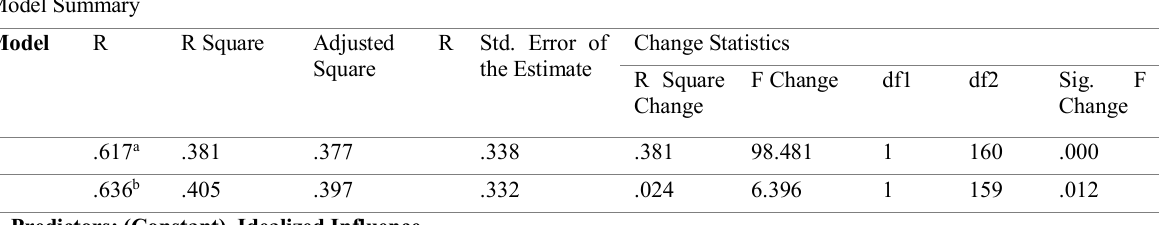
Table 4: Multiple Linear Regression Analysis of Employee Motivation as a